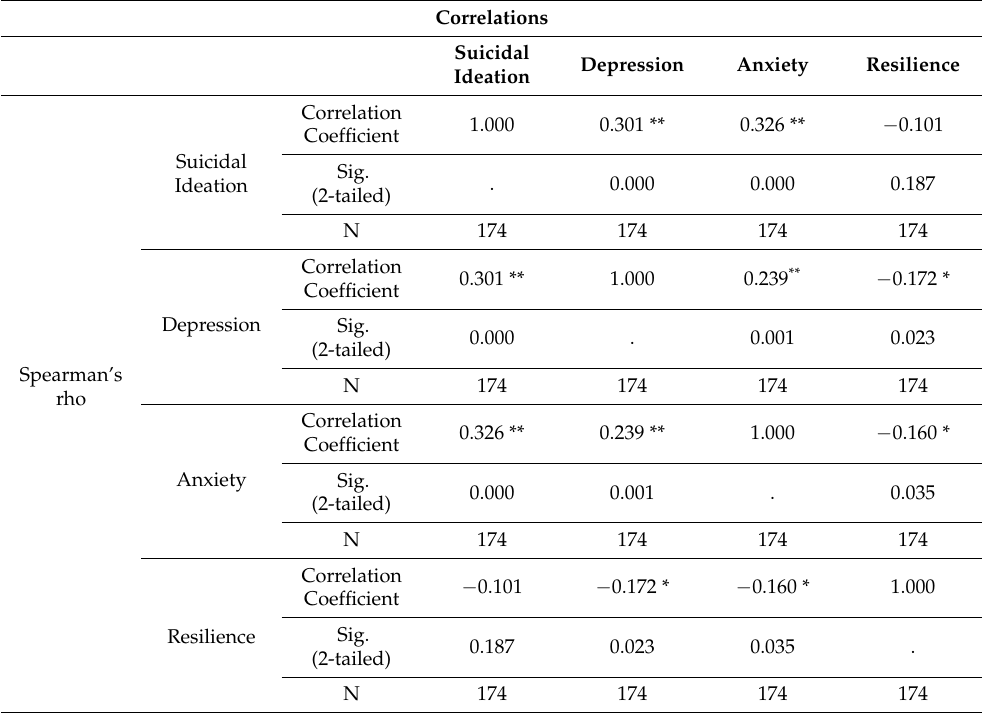
Table A2. Correlation matrix between anxiety, depression, resilience and suicidal